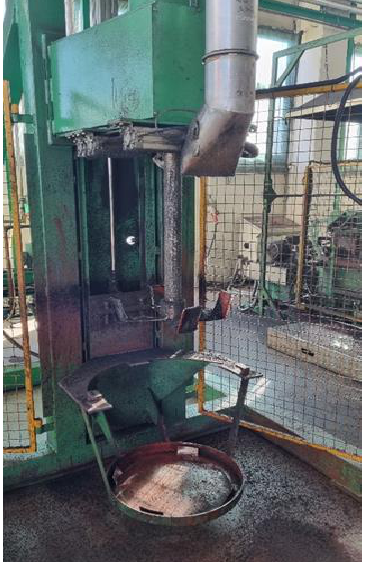
Figure 2. Industrial mixer.